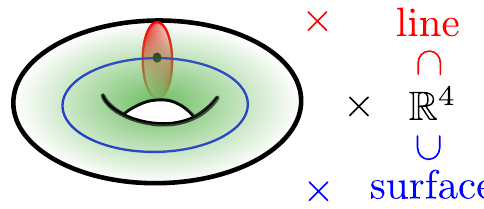
Figure 8 . When d = 2 and M 2 = T 2 is a two-torus, the solid torus D 2 × S 1 gives a pure polarization. A three-dimensional operator wrapping D 2 (red in the figure) becomes a line operator in R 4 , while those along S 1 (blue in the figure) give rise to topological surface operators that generate a 1-form symmetry. Since they intersect in the solid torus, the line operator is charged under the 1-form